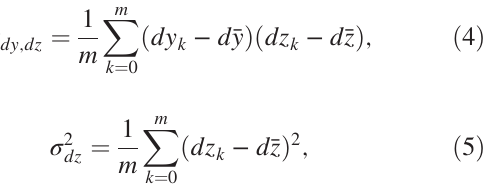
= 2 and x as free d toward the bare qubit m